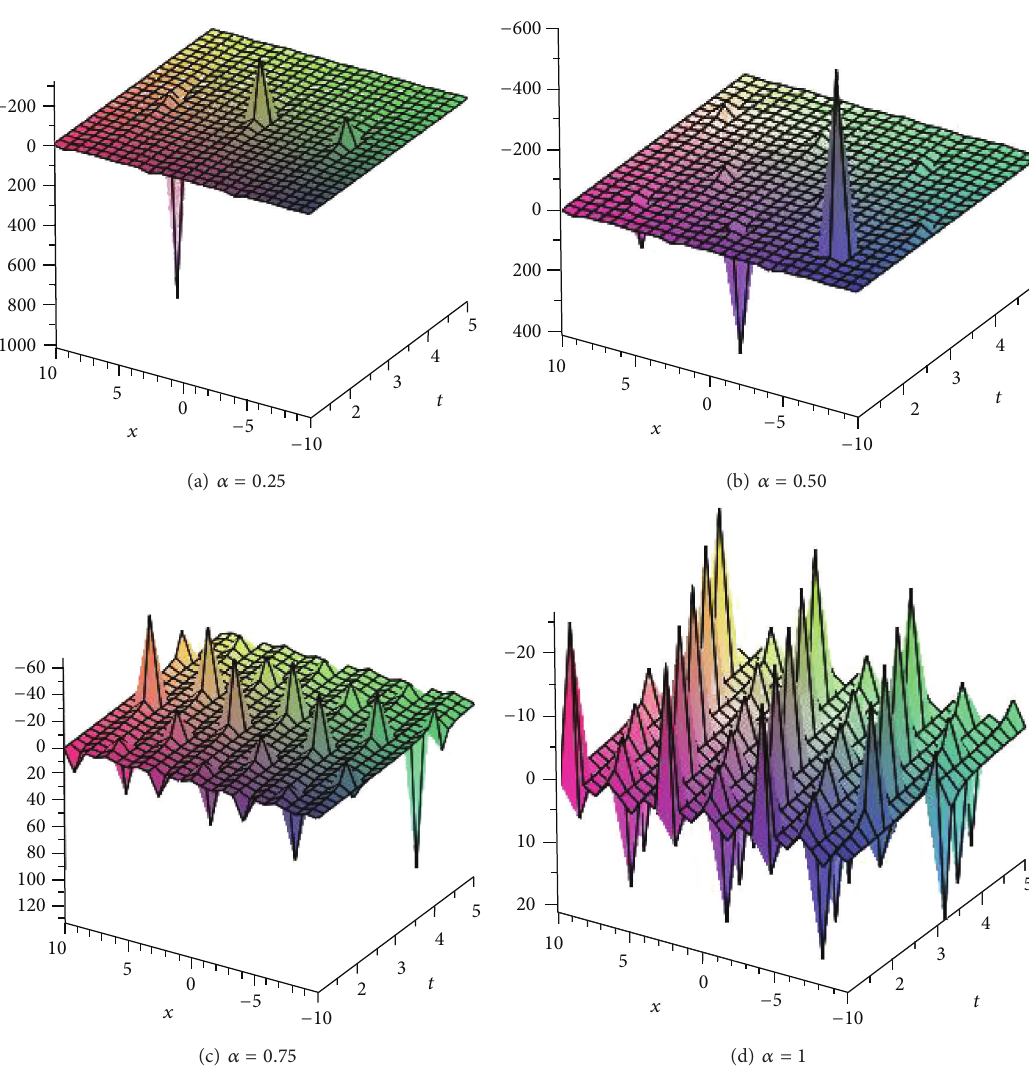
Figure 3: (a)–(d) show the periodic solution for 𝑢 12 2 for different values of